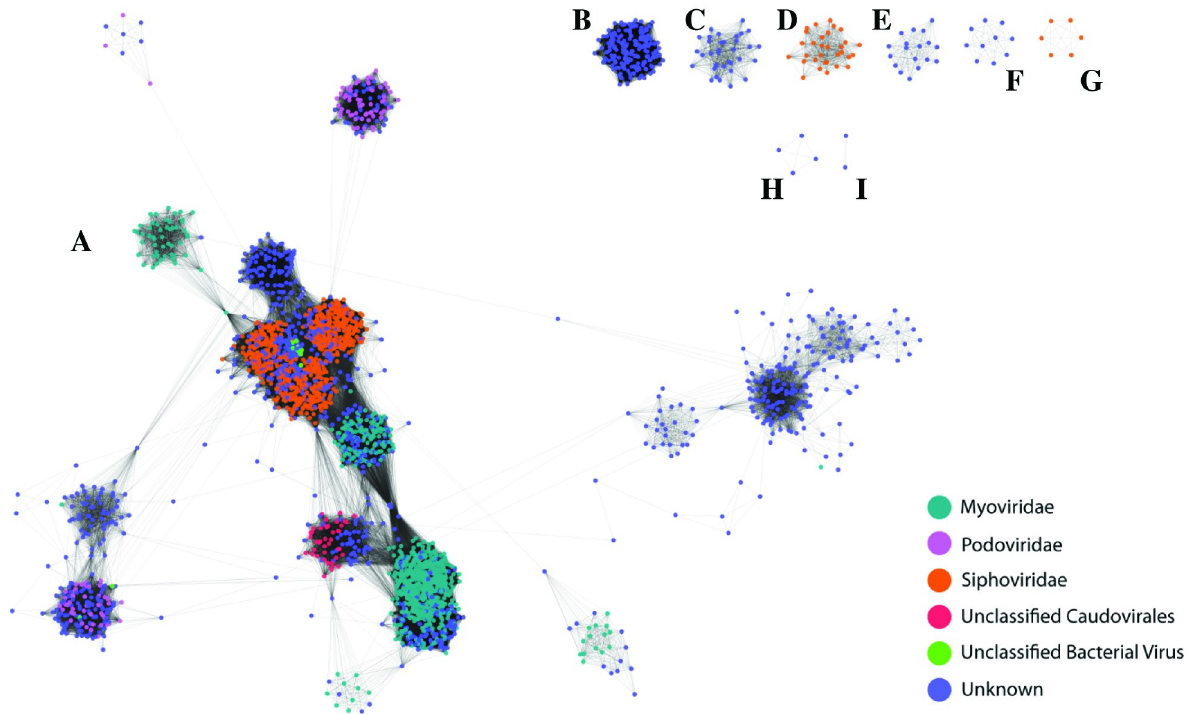
Fig 1. Diversity of urinary E . coli prophages. Each node corresponds with a predicted intact coliphage. Edges connecting nodes represent shared gene content. Individual connected components, clusters of prophages that share gene content, are indicated by letters A through I.